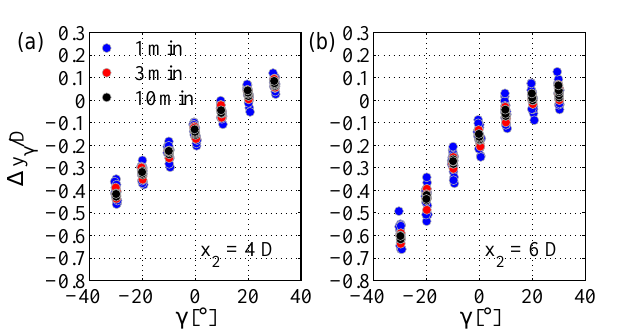
Figure 10. Same as in Fig. 6 but for the SBL simulation. Crosses mark the wake trajectories for simulations with opposite sense of rotation of the rotor.